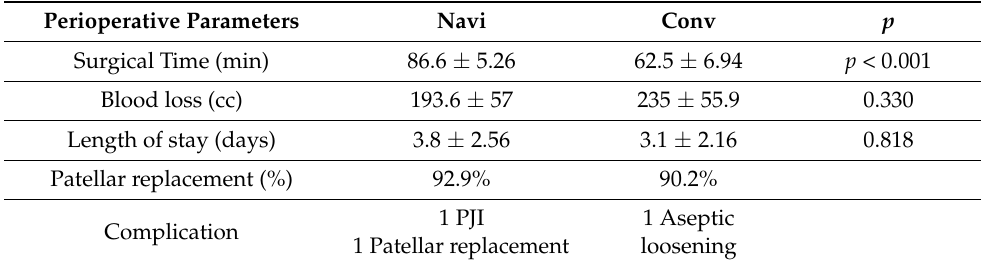
Table 2. Perioperative parameters.